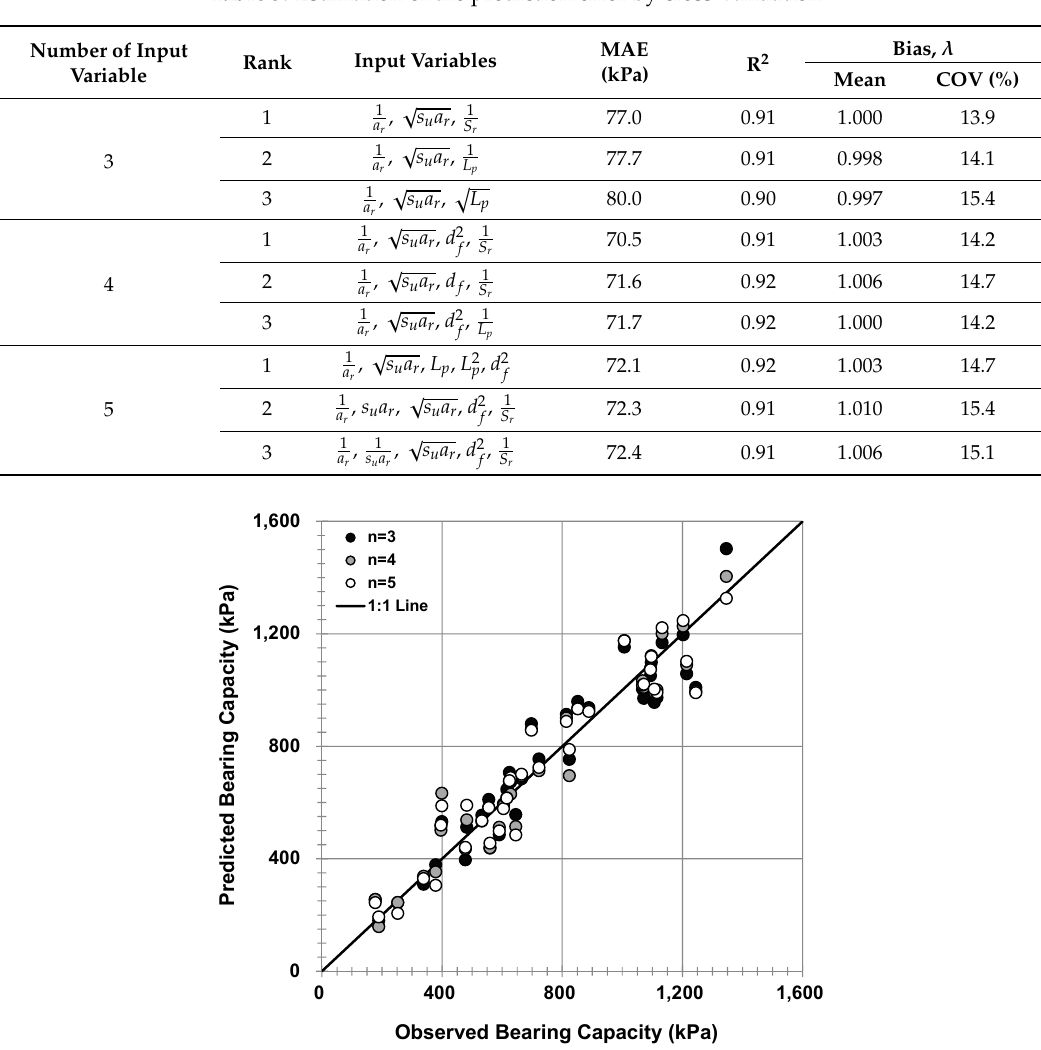
Table 4. Summary statistics for the proposed MLR model.